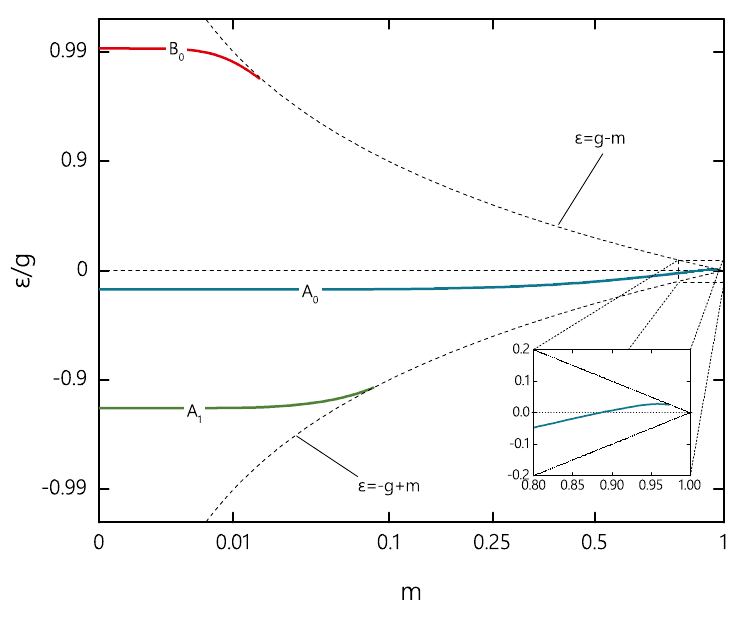
Figure 5 . Normalized energy ε m for several fermion modes at g = 1 and κ 0 = 0 . 1. The dashed lines indicate positive and negative continuum thresholds ε =